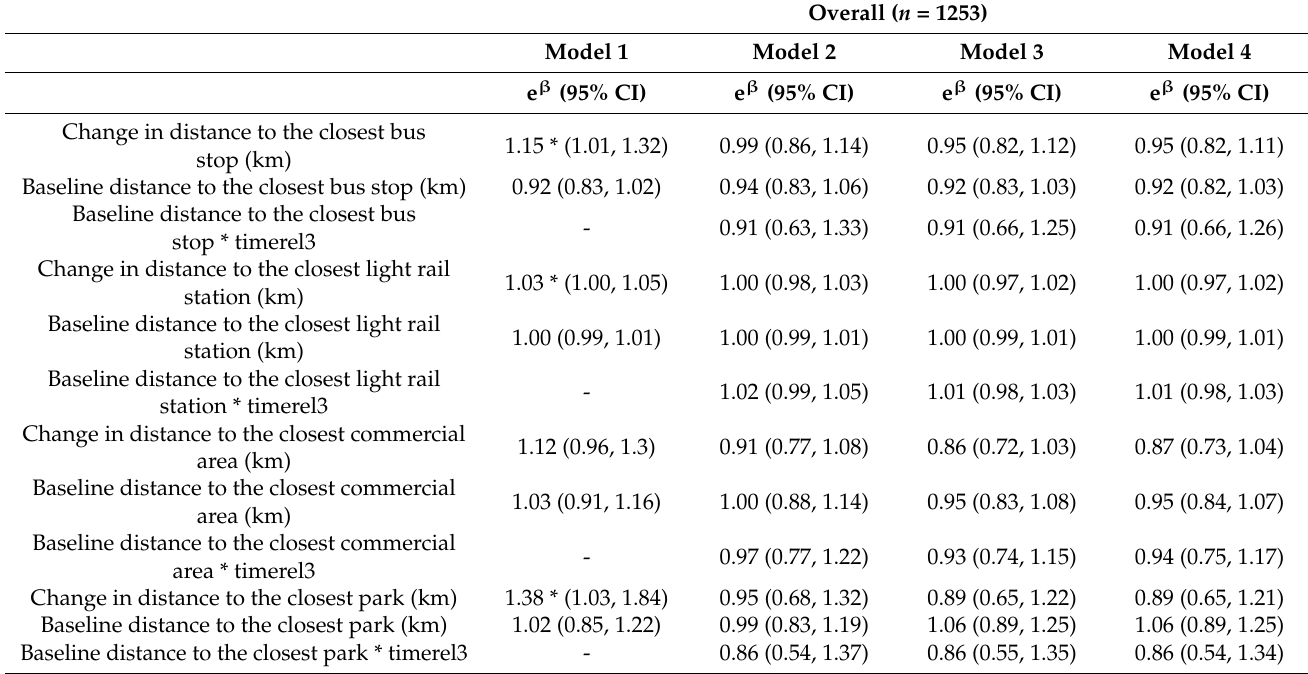
Table A6. Results from sensitivity analysis using Classification and Regression Trees for Imputation.